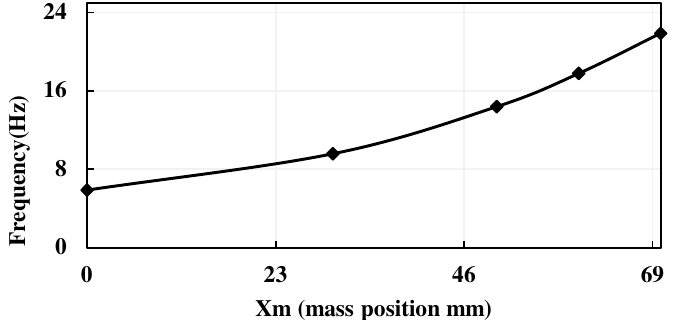
Figure 13. Relationship between the natural frequency and the mass position x m (mm) measured from the free end.